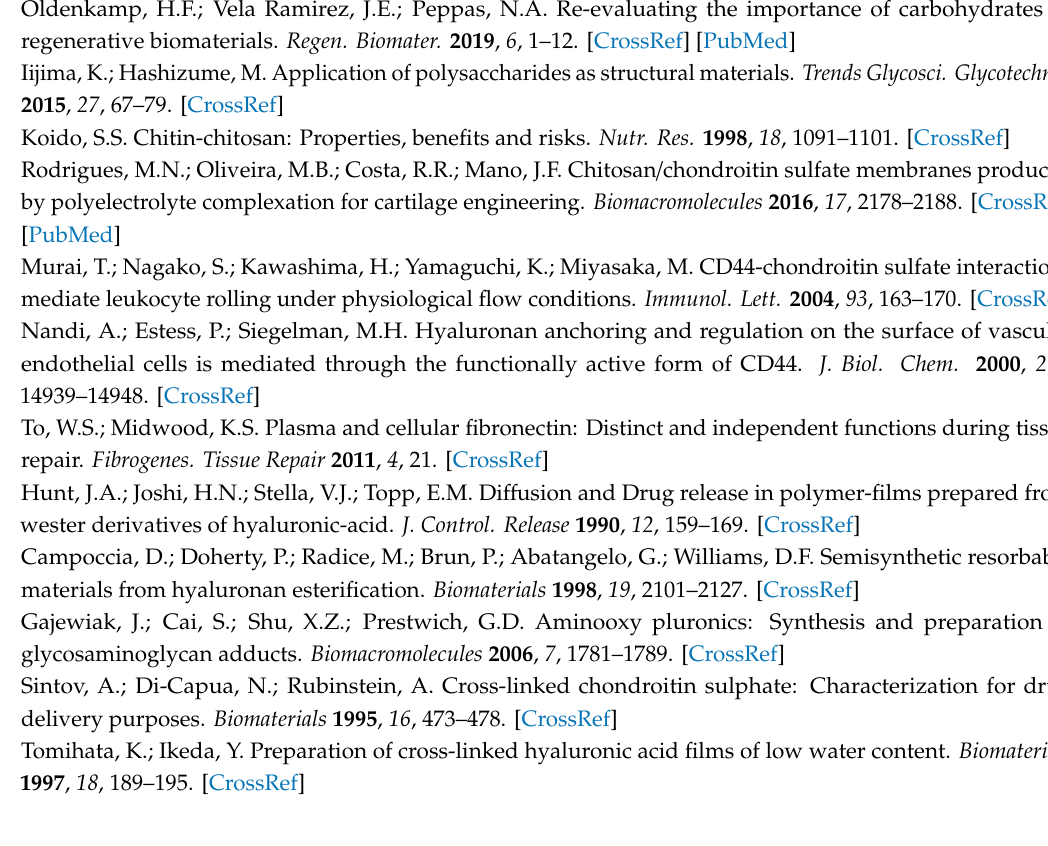
Figure S1. FT-IR spectra of powder of HEP (a), HYA (d), and CMC (g) and composite films made of HEP / CHI (b), HYA / CHI (e), CMC / CHI (h), HEP / CS / CHI(c), HYA / CS / CHI (f), and CMC / CS / CHI (i). An asterisk (*) and a pound (#) symbol show the position of the peaks originating from -NH 3 + and -SO 3 − , respectively. Figure S2. Time-lapse imaging of the formation of the CS / CHI composite films from CS / CHI PICs particle dispersion: 0 min (a), 80 min (b), 160 min (c), 240 min (d), and 320 min (e). A movie is also available as supplementary data. Figure S3. Typical 3D (a) and 2D (b) atomic force microscopic images and surface profiles (c) of CS / CHI film surface from an approximately 2 µ m × 2 µ m scanned area. Table S1. Atomic fractions of elements detected on the surface of CS / CHI, HYA / CHI, and HYA / CS / CHI films by XPS. Video S1. Time-lapse movie of the formation of the CS / CHI composite films from CS / CHI PICs particle